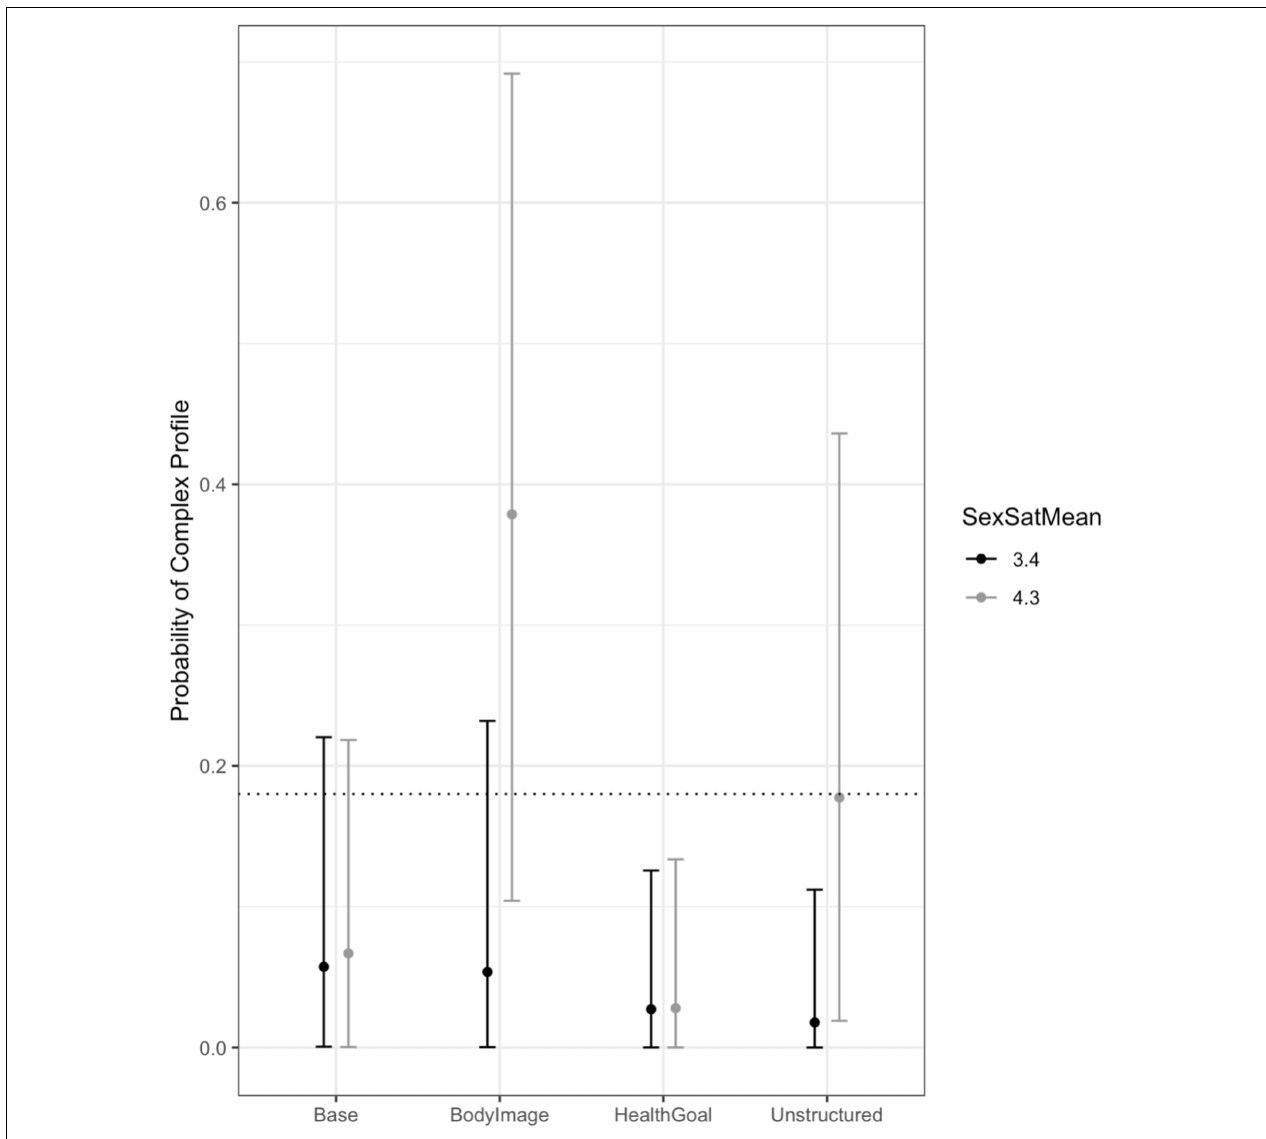
FIGURE 4 | The interaction of average sexual satisfaction and context. The dotted line shows the unconditional probability of being in the complex profile as a reference point. Higher average sexual satisfaction was associated with a higher probability of being in the complex profile during the Body Image